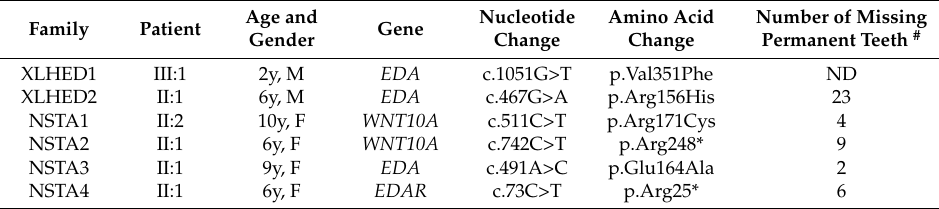
Table 1. Summary of clinical data and mutations in EDA , EDAR , and WNT10A genes. Family